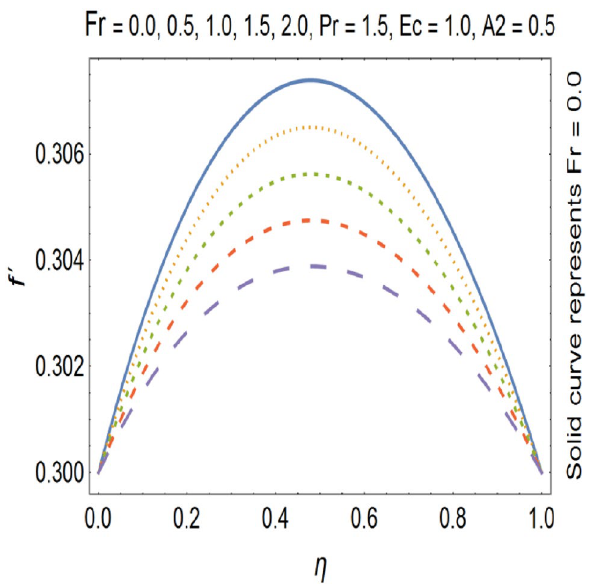
Figure 11. Velocity profile for various F r .